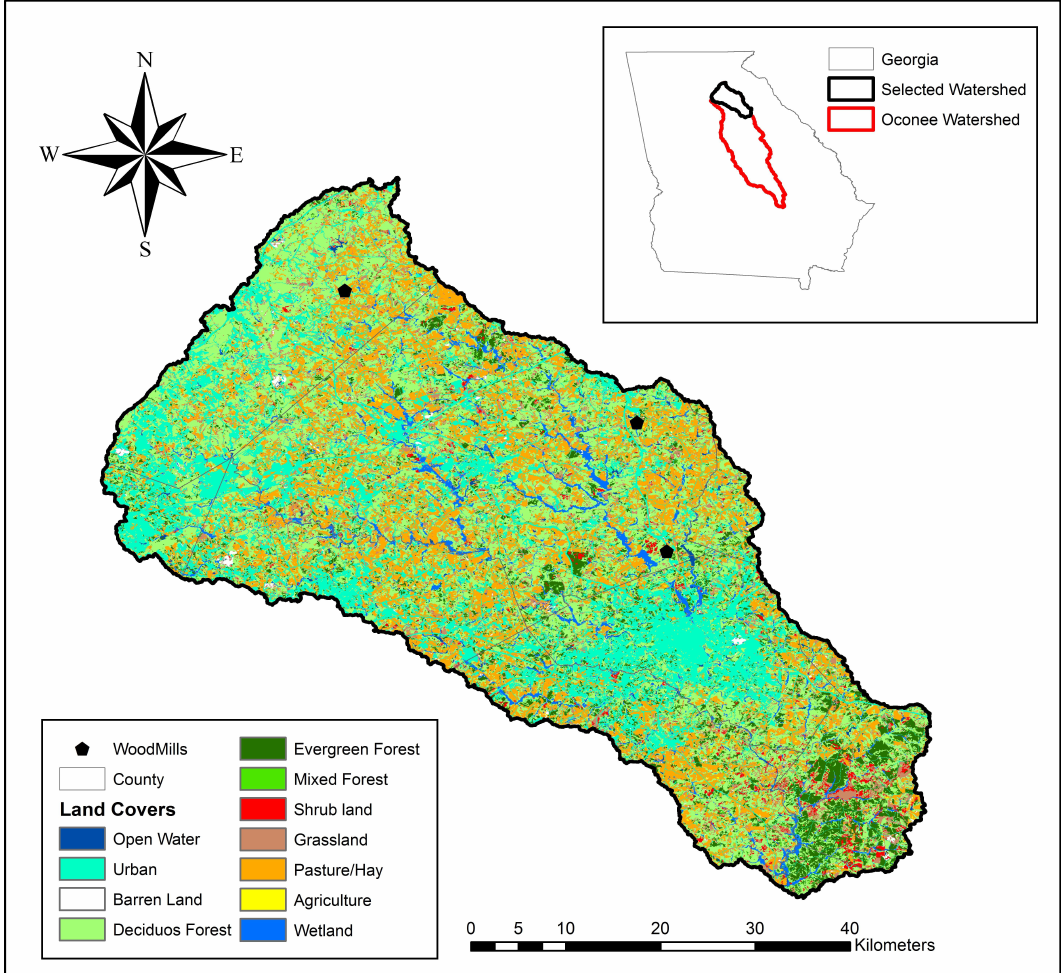
Figure 1. Location of the selected watershed in the Oconee River Basin. The 2011 land cover map is derived from National Land Cover Dataset available at https://gdg.sc.egov.usda.gov/.